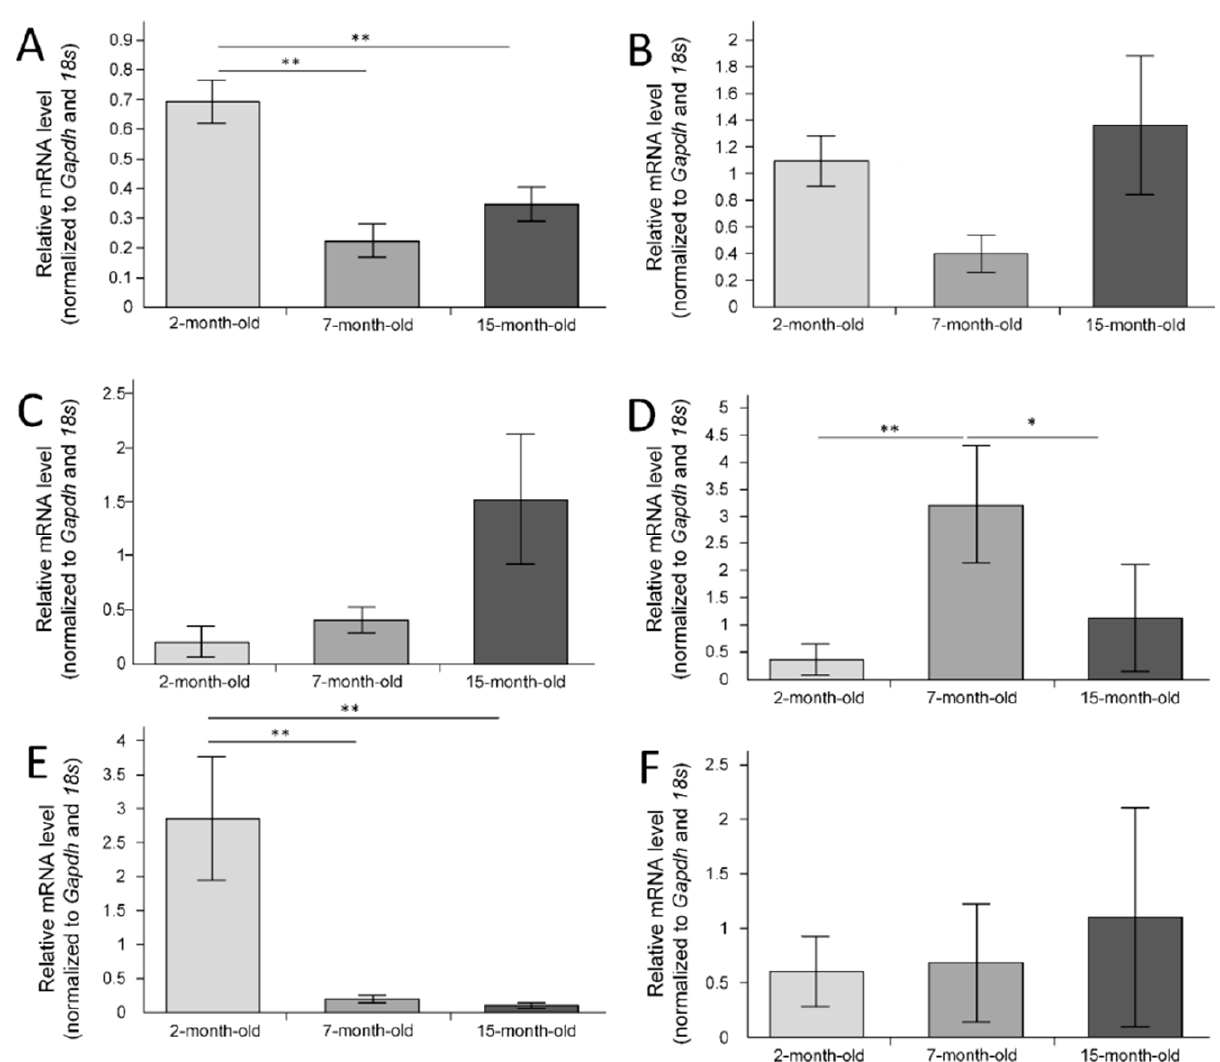
Figure 3. The normalized gene expression in the hippocampus: ( A ) Akt1 ; ( B ) Mtor ; ( C ) Nfe2l2 ; ( D ) Pten ; ( E ) Bdnf ; ( F ) Il1b . The 2-month-old mice (n = 9), 7-month-old mice (n = 9), 15-month-old mice (n = 9). * p < 0.05; ** p < 0.01 differences between age groups were statistically significant according to the Mann–Whitney test.